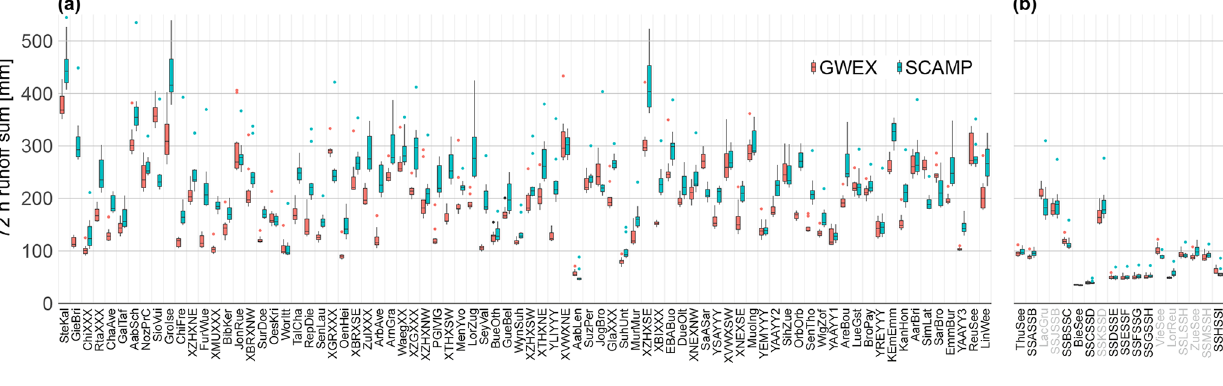
Figure 14. Comparison of hydrological results achieved with GWEX inputs (red) and SCAMP inputs (blue). Shown are boxplots for the 10 largest 72h runoff sums (median representative parameter set), each for the outlets of the 80 individual HBV sub-catchments ( a : ordered by increasing catchment area) and the 19 RS MINERVE nodes (i.e. critical sites including the Aare River outlet) ( b : ordered by location along the Aare River; tributaries are designated with a grey label colour). For the sub-catchment and output node abbreviations, see Tables S2 and